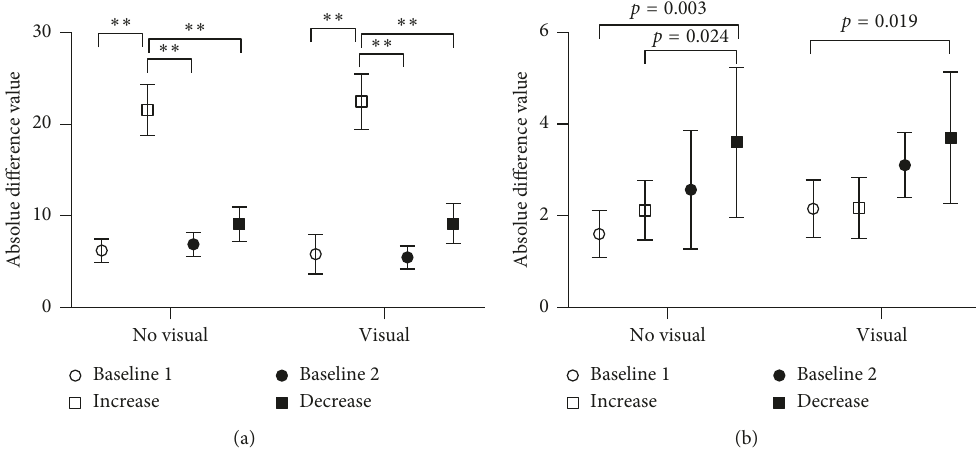
Figure 3: Pairwise comparison of (a) heart rate and (b) SaO Table 4: Repeated measures mixed model results for recording setting, music, and training level on oxygen saturation estimation accuracy. Effect Scenario Setting Visual